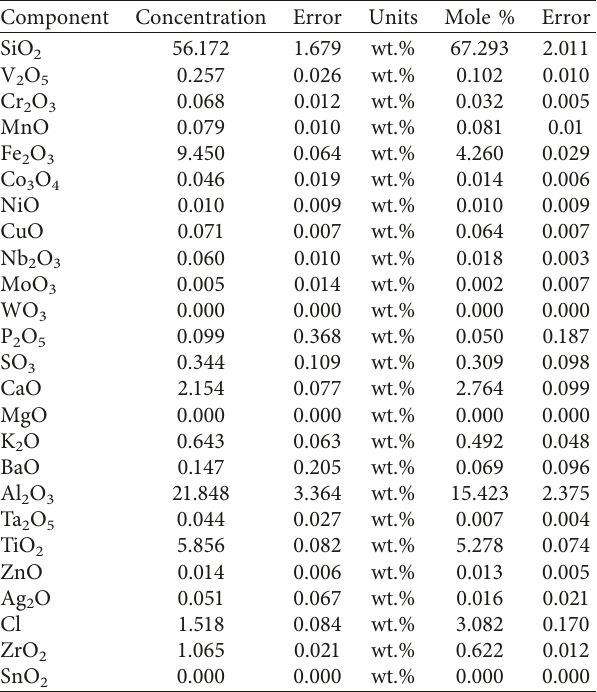
Table 8: General test soil